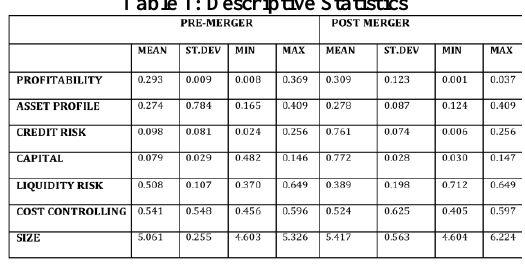
Table 1: Descriptive Statistics